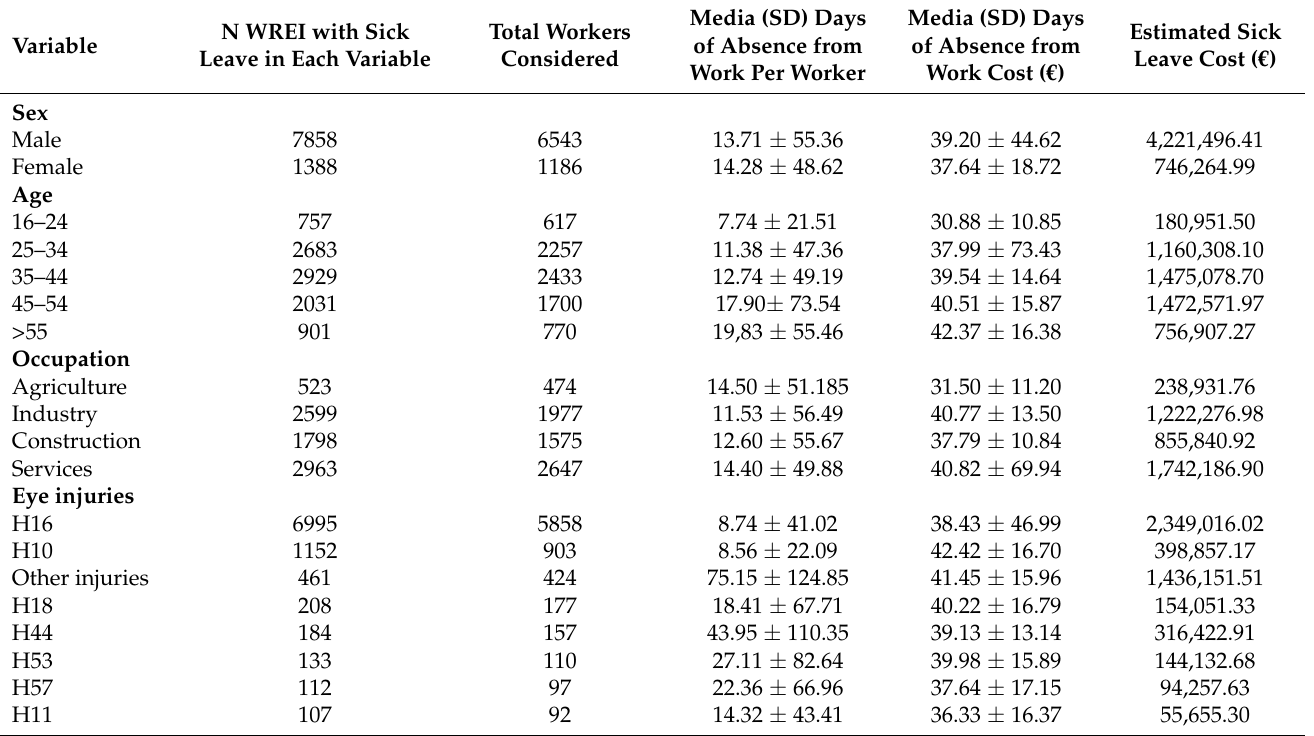
Table 3. Total labor costs estimated by each